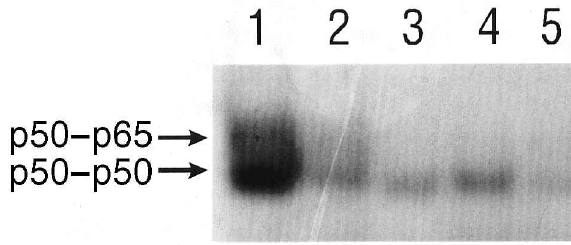
FIG. 6. Electrophoretic mobility shift assay ± Effects of NF- k B inhibitors on NF- k B binding. RAW 264.7 cells were incubated for 2 h with either no treatment (lane 1); PDTC, 25 m M (lane 2); PDTC, 50 m M (lane 3); PDTC, 100 m M (lane 4); TPCK, 5 m M (lane 6); TPCK, 10 m M (lane 7); TPCK, 25 m M (lane 8); TPCK, 50 m M (lane 9); calpain I inhibitor, 1 m M (lane 10); calpain I inhibitor, 5 m M (lane 11); calpain I inhibitor, 10 m M (lane 12); calpain I inhibitor, 25 m M (lane 13). Bands corresponding to p50 ± p65 heterodimers and to p50 ± p50 homodimers are indicated by arrows. The uppermost band seen in lanes 7, 9 and 12 is unidenti® ed. This experiment was repeated at least three